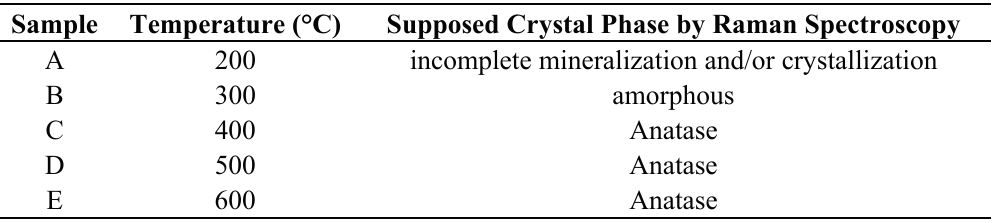
Figure 4. Raman spectra. Table 2. Characteristic of the studied TiO 2 thin layers prepared by sol-gel method.